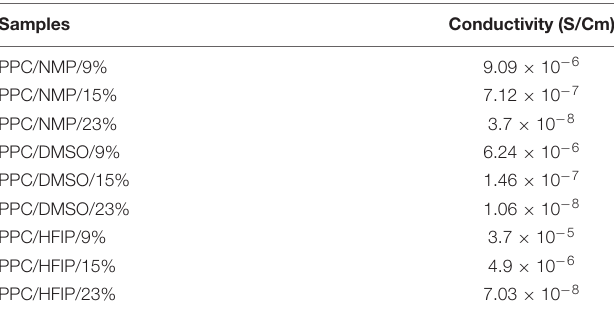
TABLE 1 | Conductivity of electrospun scaffolds.